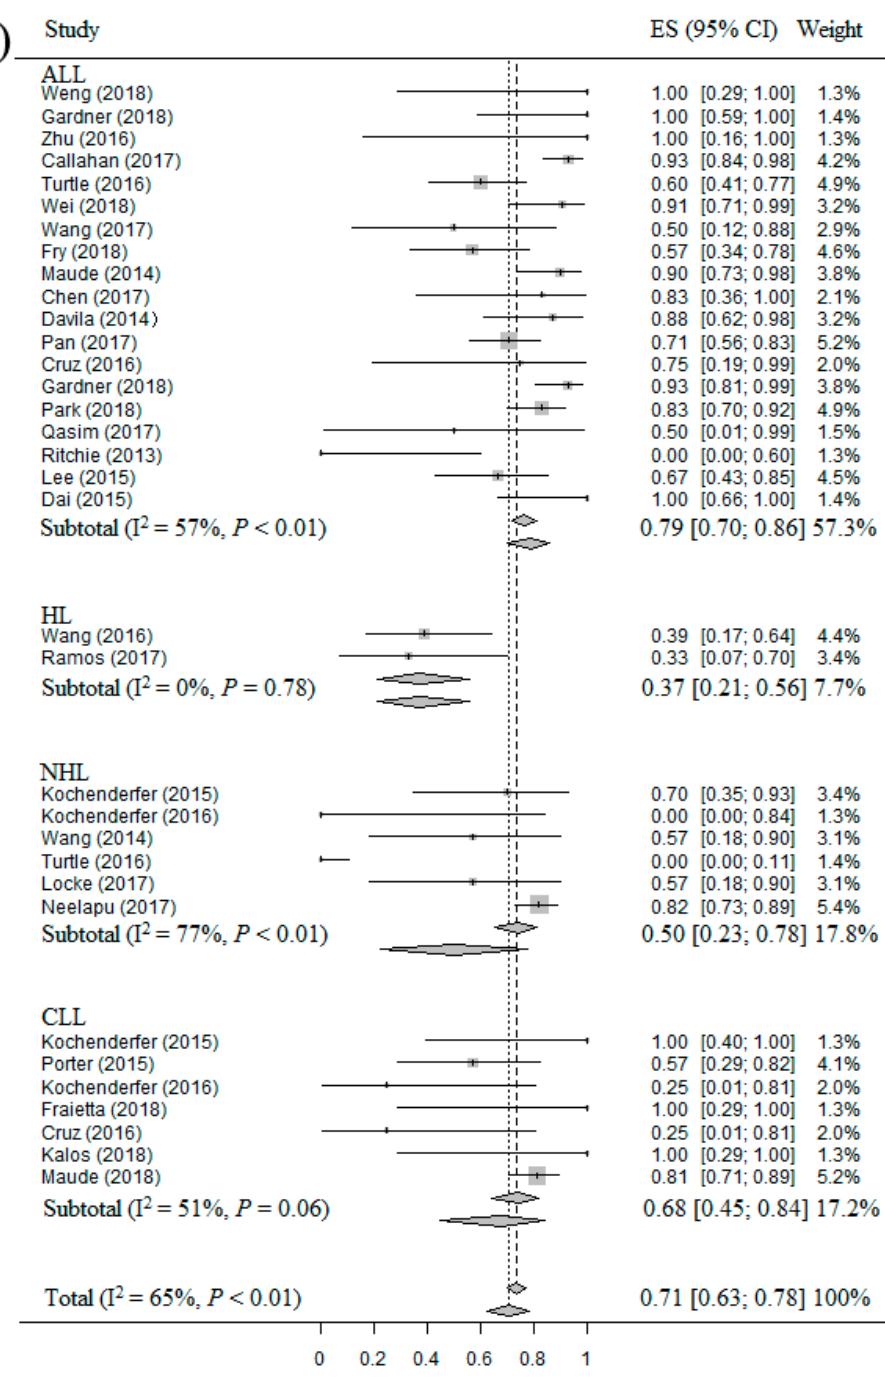
Figure 2. The forest plots of meta-analysis about ORR: ( a ) Forest plot for ORR and CI in solid and hematologic malignancies patients of each study and the overall; ( b ) Forest plot for ORR and CI in different B-cell malignancies patients of each study and the overall.